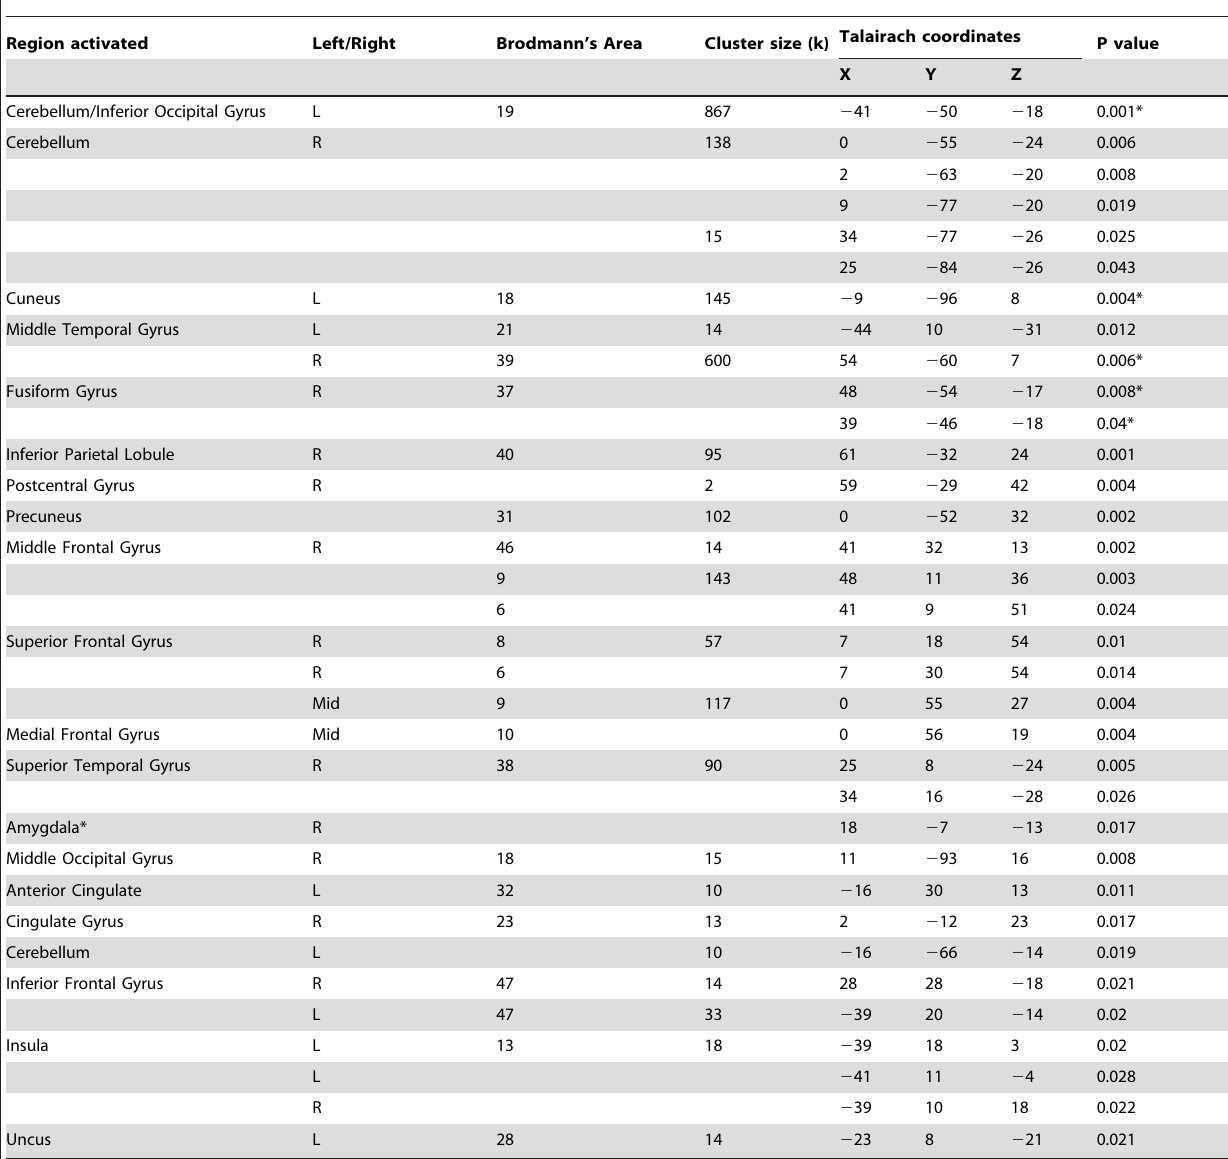
Table 2. Areas of significant activation from all infants minus neutral contrast (FDR corrected p , 0.05).